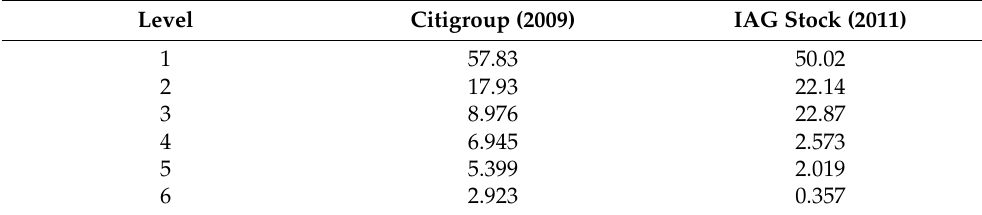
Table 14. Total energy for Citigroup and IAG stock markets